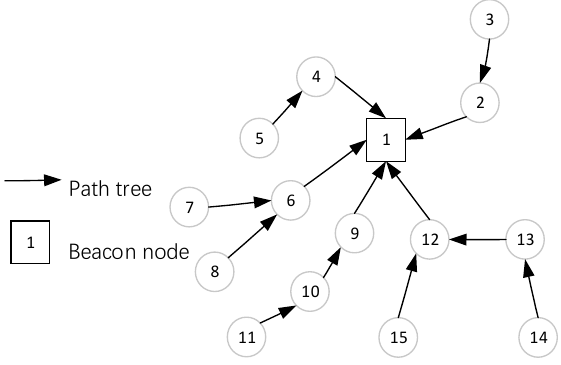
5 of 13 Figure 3. Schematic diagram of pulse unit. In the beacon-based routing protocol, the non-beacon node would actively maintain